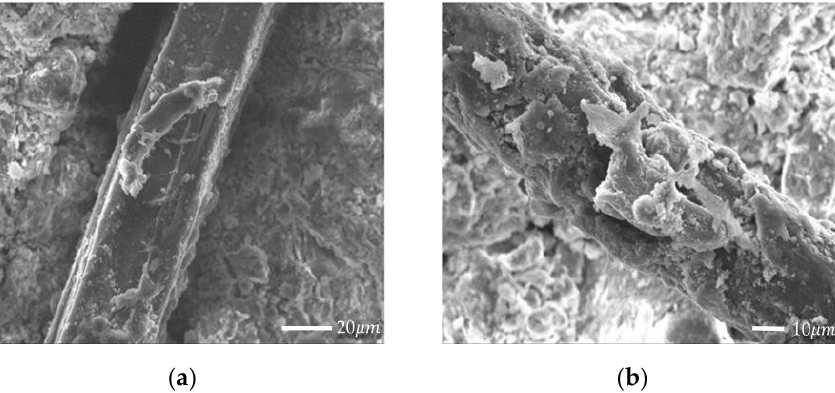
Figure 12. Interface between the fiber and soil-cement: ( a ) jute fiber (×800); ( b ) PVA fiber (×1000).